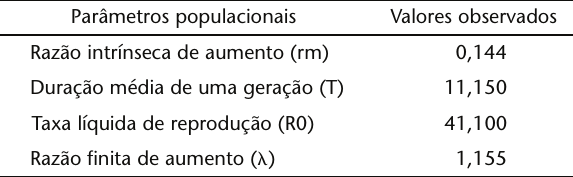
Tabela III. Parâmetros populacionais de T. desertorum criados em folhas de feijão ( P. vulgaris ) cultivar Tacarigua a 28 ± 2ºC, 70 ± 10% U.R. e 12:12 h.